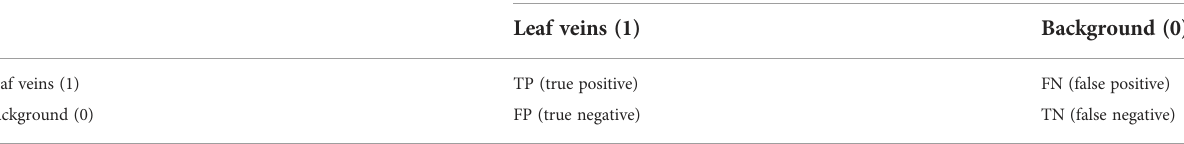
TABLE 1 Leaf veins segmentation confusion